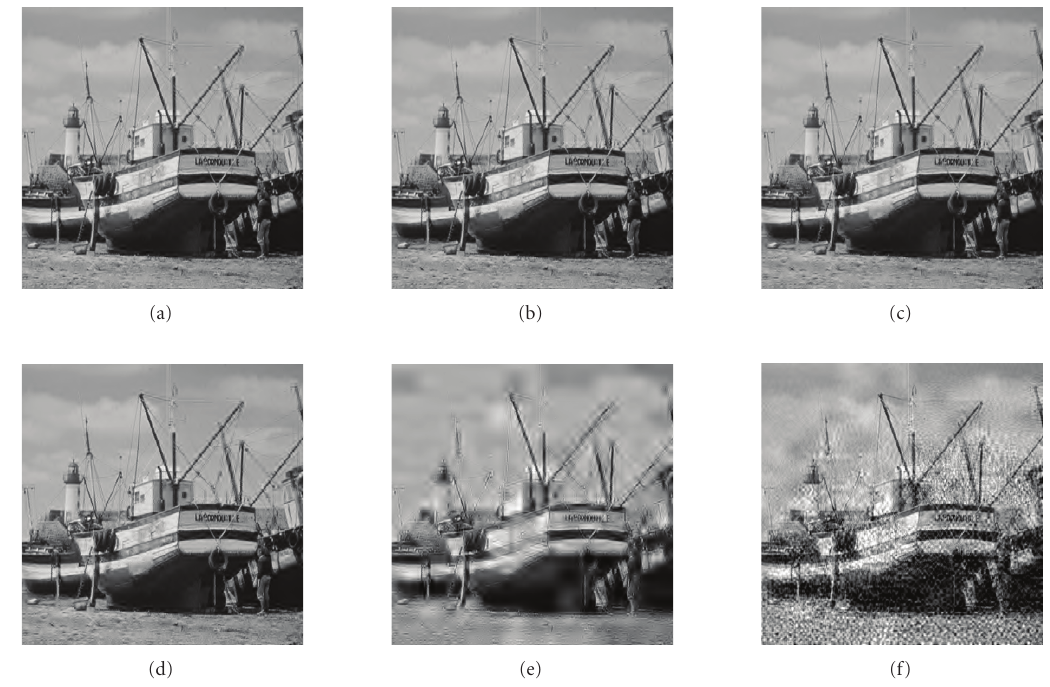
Figure 9: Sample images at SNR 11 dB with code block size 64 × 64 (Boat motif). (a) Tree decoder 15 iterations PSNR 31.4461 dB, (b) tree decoder 10 iterations PSNR 31.4318 dB, (c) tree decoder 5 iterations PSNR 30.3724 dB, (d) heuristic decoder PSNR 30.6885 dB, (e) baseline error-resilient decoder PSNR 23.301 dB, (f) baseline decoder PSNR 20.0612